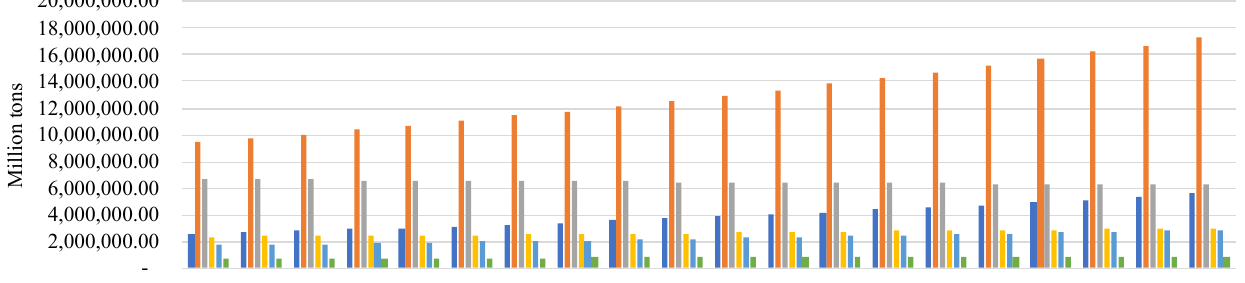
Figure 2. Projection of merchandise growth (million tons) in the port of Veracruz.